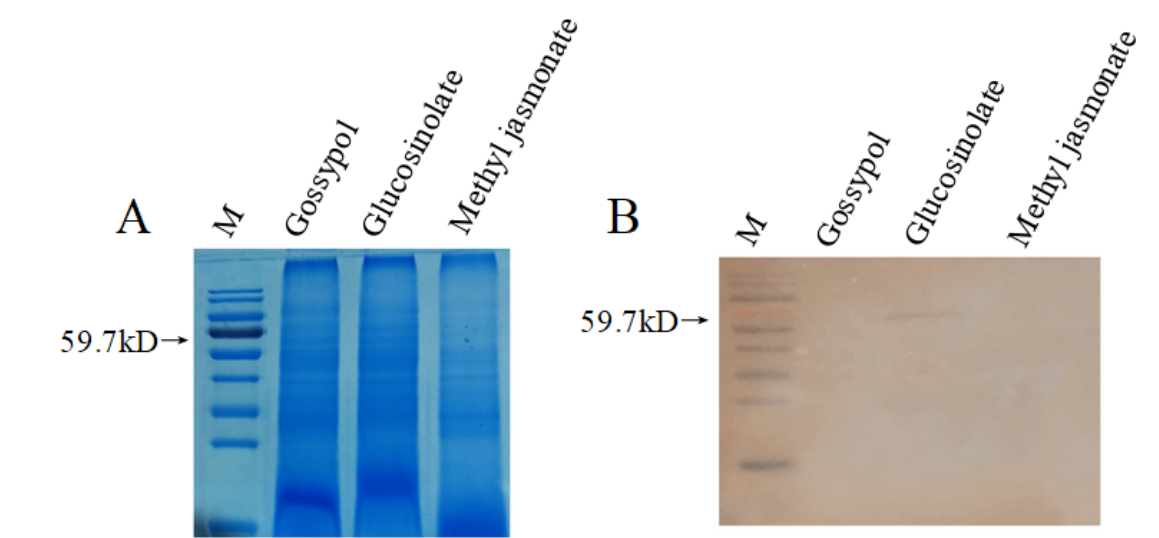
Figure 9. SDS-PAGE and Western blot analysis of cotton bollworm midgut wall and midgut contents. ( A ) SDS-PAGE analysis of cotton bollworm midgut wall and midgut contents; ( B ) Detection of cotton bollworm midgut wall and midgut contents in vitro by Western blot analysis using anti-sulfatase antiserum. M: Protein marker.